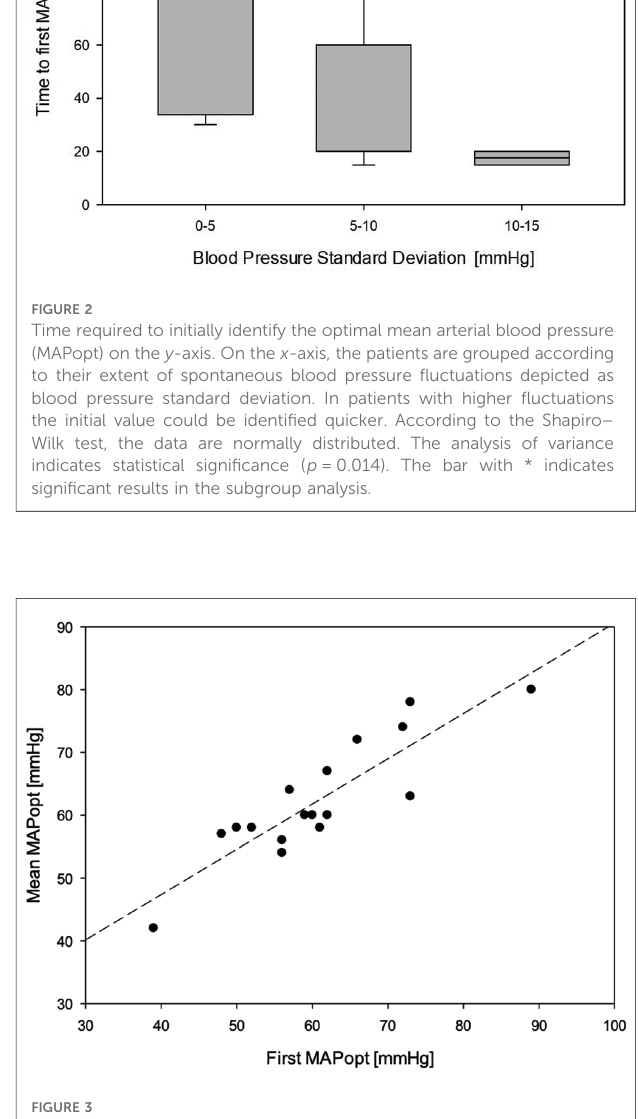
FIGURE 3 Scatterplot of the optimal mean arterial blood pressure (MAPopt), which could be identi fi ed throughout the complete surgery on the y -axis and the initially identi fi ed MAPopt on the x -axis. A linear regression analysis was performed, and a dotted regression line was added to the graph. The correlation coef fi cient is R